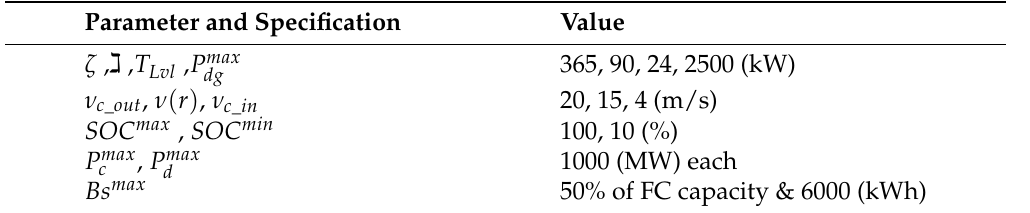
Table 1. Case study parameters.